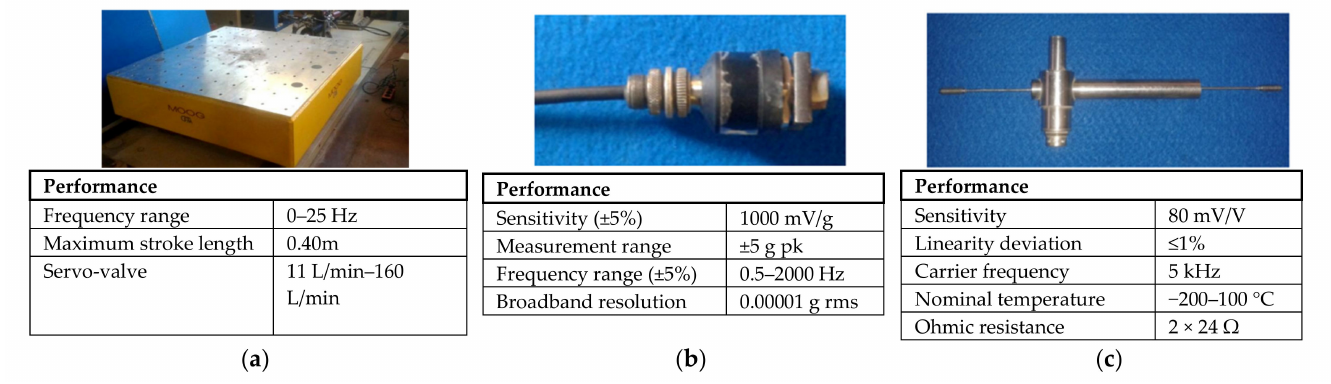
Figure 6. ( a ) Shaking table, ( b ) piezotronic accelerometer, ( c ) Linear Variable Displacement Transducer.